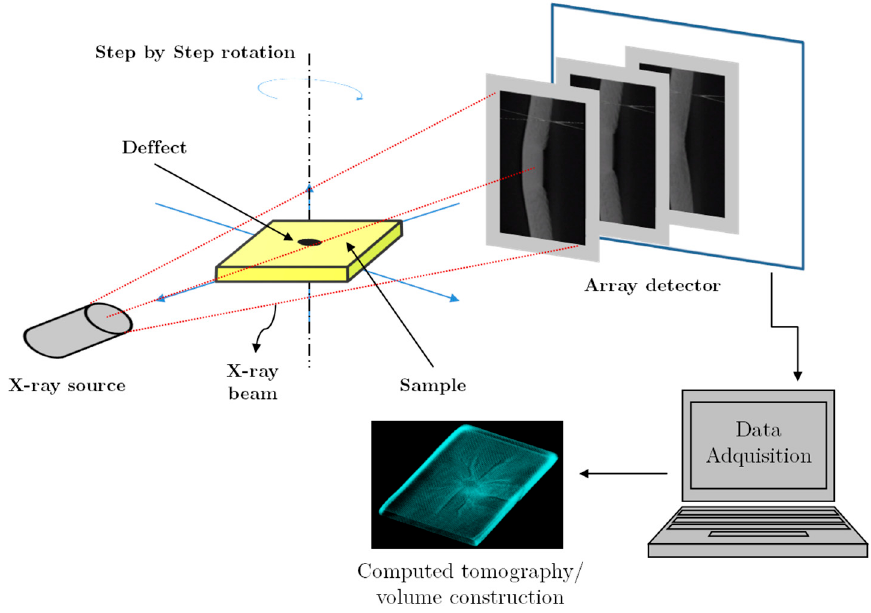
Figure 5. Computerised micro-tomography (CT) process scheme for measurement and acquisition. Table 2. Microtomography µ CT scanning parameters to damage